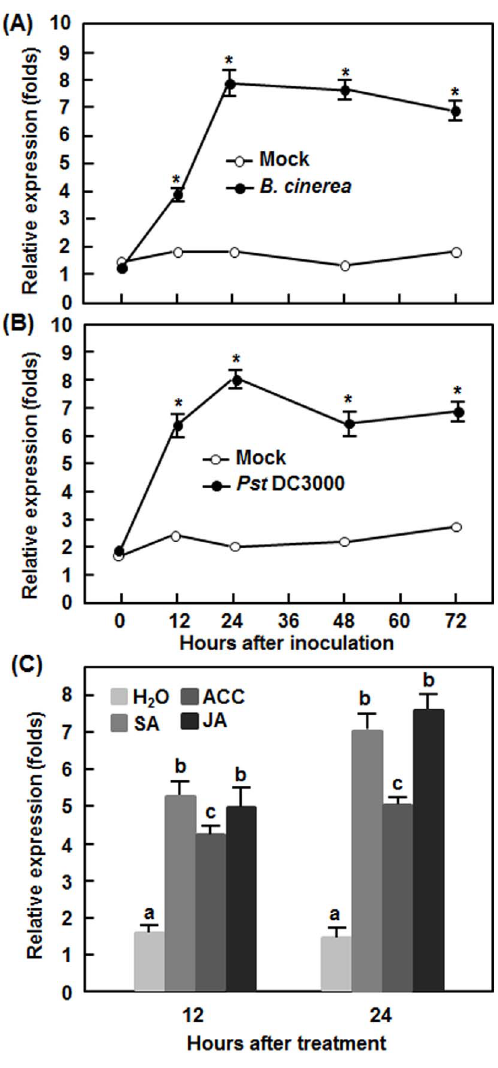
Figure 3. Expression of SlSRN1 in responses to pathogen infection and treatments with defense signaling hormones. Four-week-old tomato seedlings were inoculated by spore suspension of B. cinerea (A), bacterial suspension of Pst DC3000 (B) or similar volume of buffer solution as mock-inoculation control or treated by foliar spraying with 1 mM SA, 100 m M MeJA, 100 m M ACC solutions or sterilized distill water as a control (C). Leaf samples were collected at different time points after inoculation or treatment as indicated. Total RNA was extracted and used for qRT-PCR analysis. Data presented are the means 6 SD from three independent experiments and different letters above the columns indicate significant differences at p , 0.05